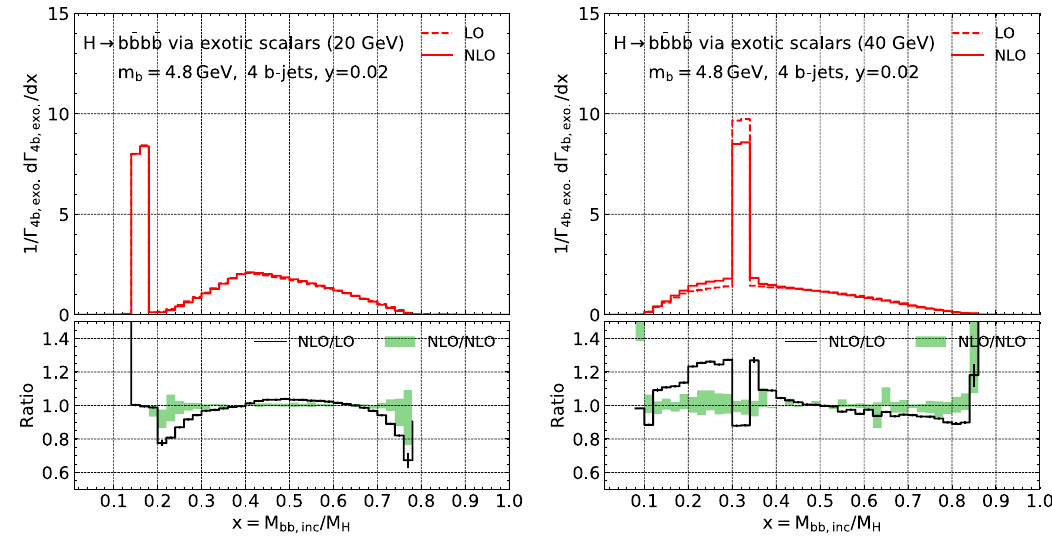
Figure 20 . Normalized distribution of the Higgs boson decay to four bottom quarks as a function of the inclusive invariant mass of all b -jet pairs, via new light scalars with a mass of 20 GeV (left plot) and 40 GeV (right plot), at both LO and NLO.